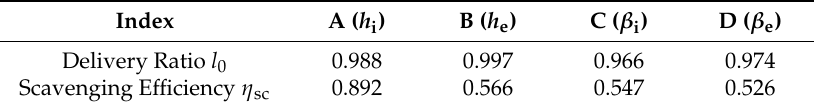
Table 6. Correlation coefficient.